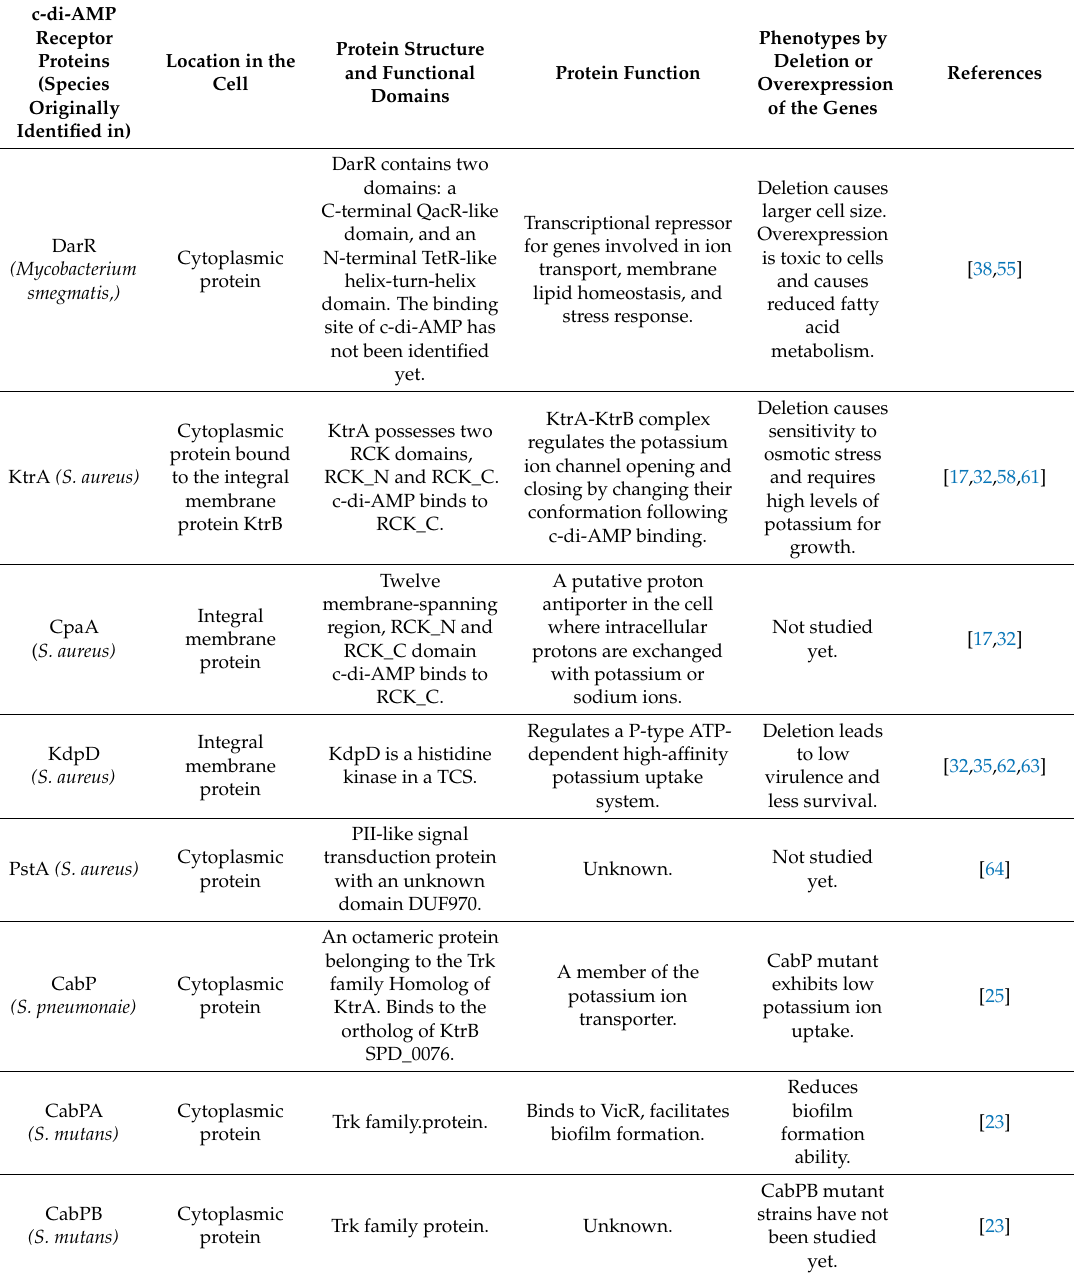
Table 2. c-di-AMP binding